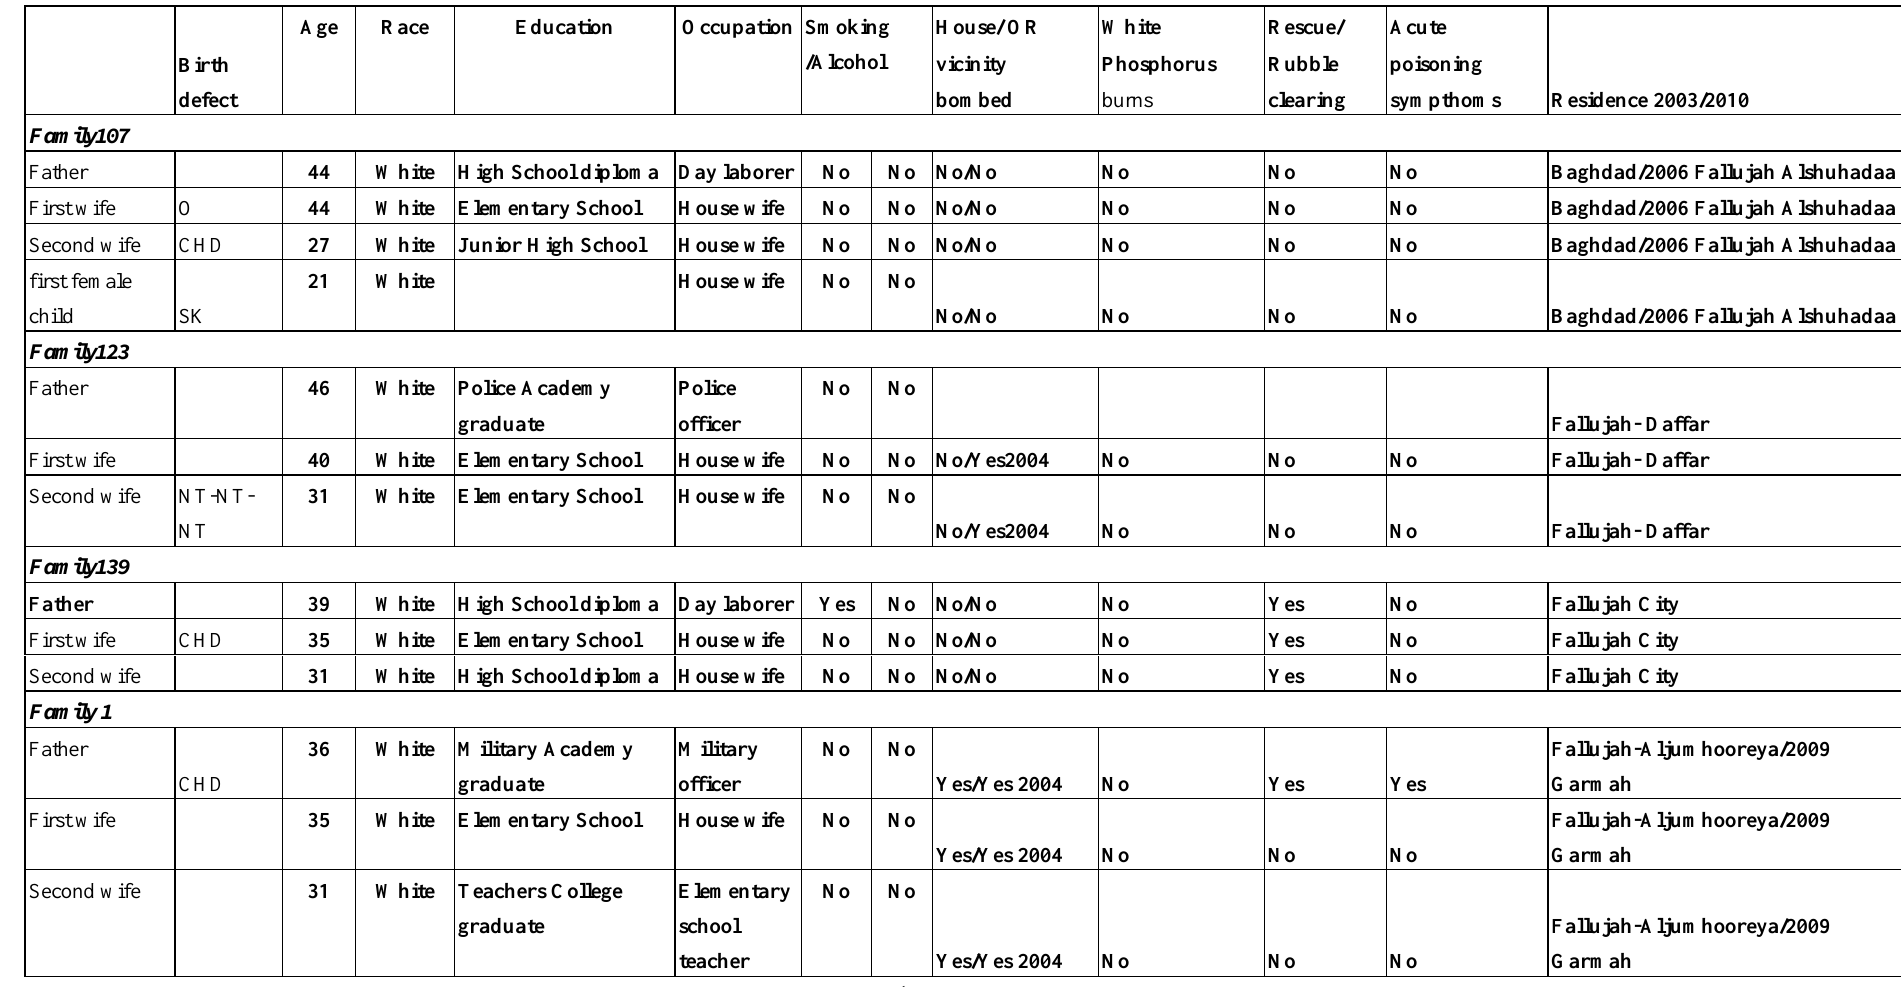
Table I. Demographics and life style habits of four Fallujah families ( NT = Neural tube defect; CHD = Congenital heart defect; SK = Skeletal defect; O = Other